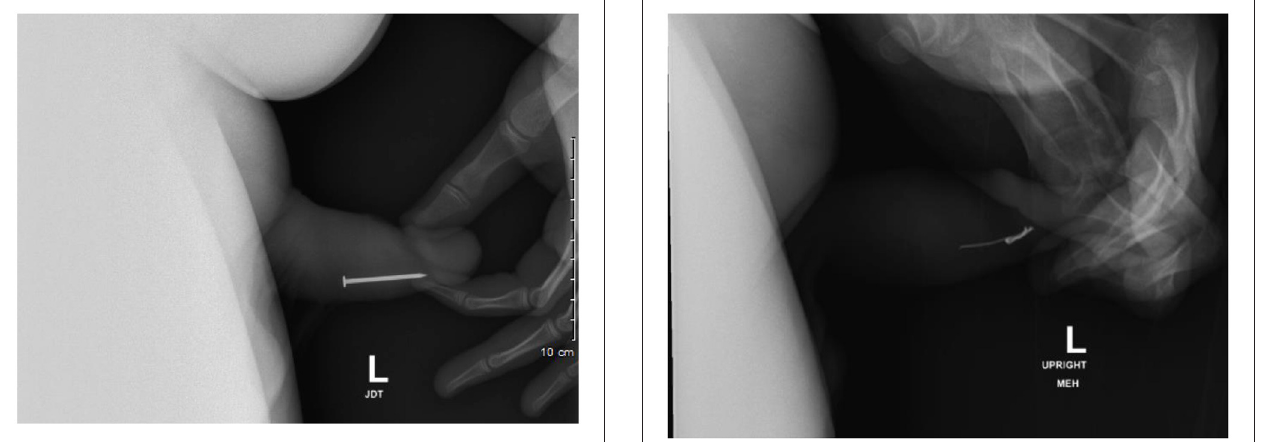
up to 1 L of urine without showing signs of discomfort. The screw was located in the distal urethra and positioned so